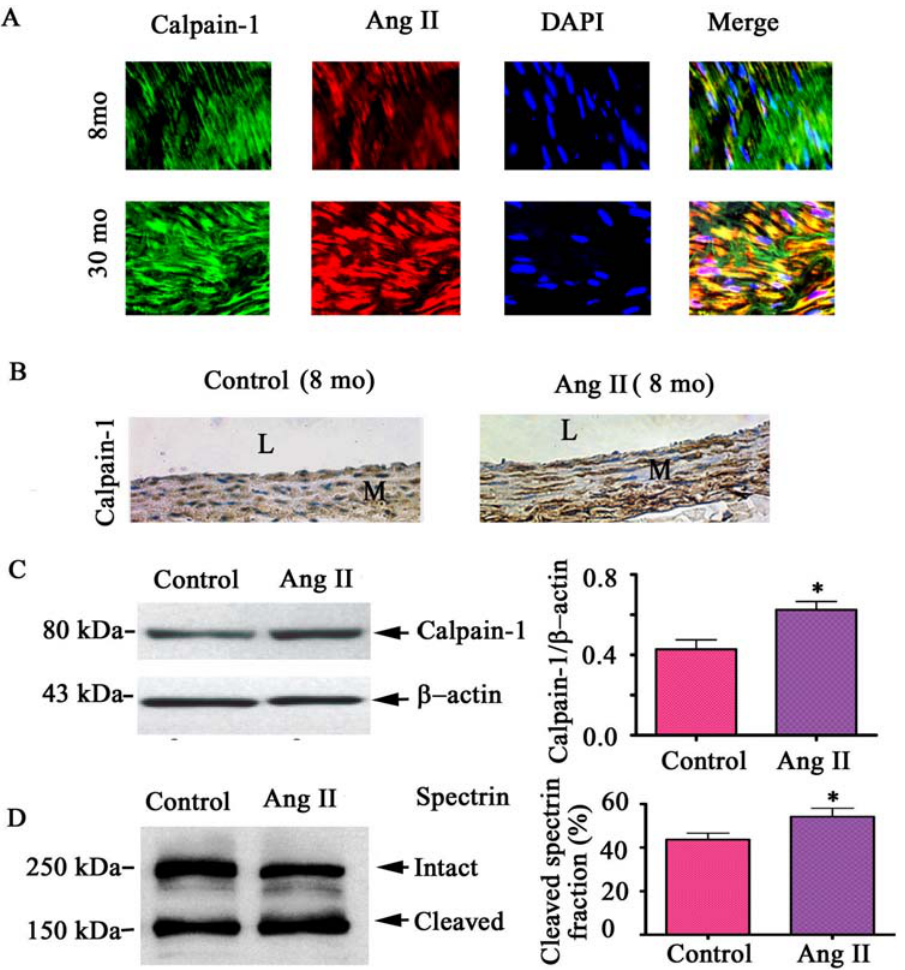
Figure 2. Calpain-1 induction in vivo by Ang II. A. Dual fluorescence labeled calpain-1 (green) and Ang II (red) in the en face medial aortic sections from young (upper panels) and old rats (lower panels). Merged image (right panels, yellow). Nuclei were counterstained with DAPI (blue). Magnification: 6 400. B. Photomicrographs (X400) of carotid sections stained for calpain-1 protein (brown color) from young rats infused chronically with Ang II 200 ng/kg/min for 28 days. L=lumen; and M=media. C. Western blots of calpain-1 and b -actin of carotid lysates from young rats infused with saline solution (control) and Ang II (left panel); right panel shows average data. D . Western blots of the calpain substrate, a -II spectrin, of carotid arteries (left panels). Average cleaved spectrin fraction (right panel). *p , 0.05, Ang II vs. saline